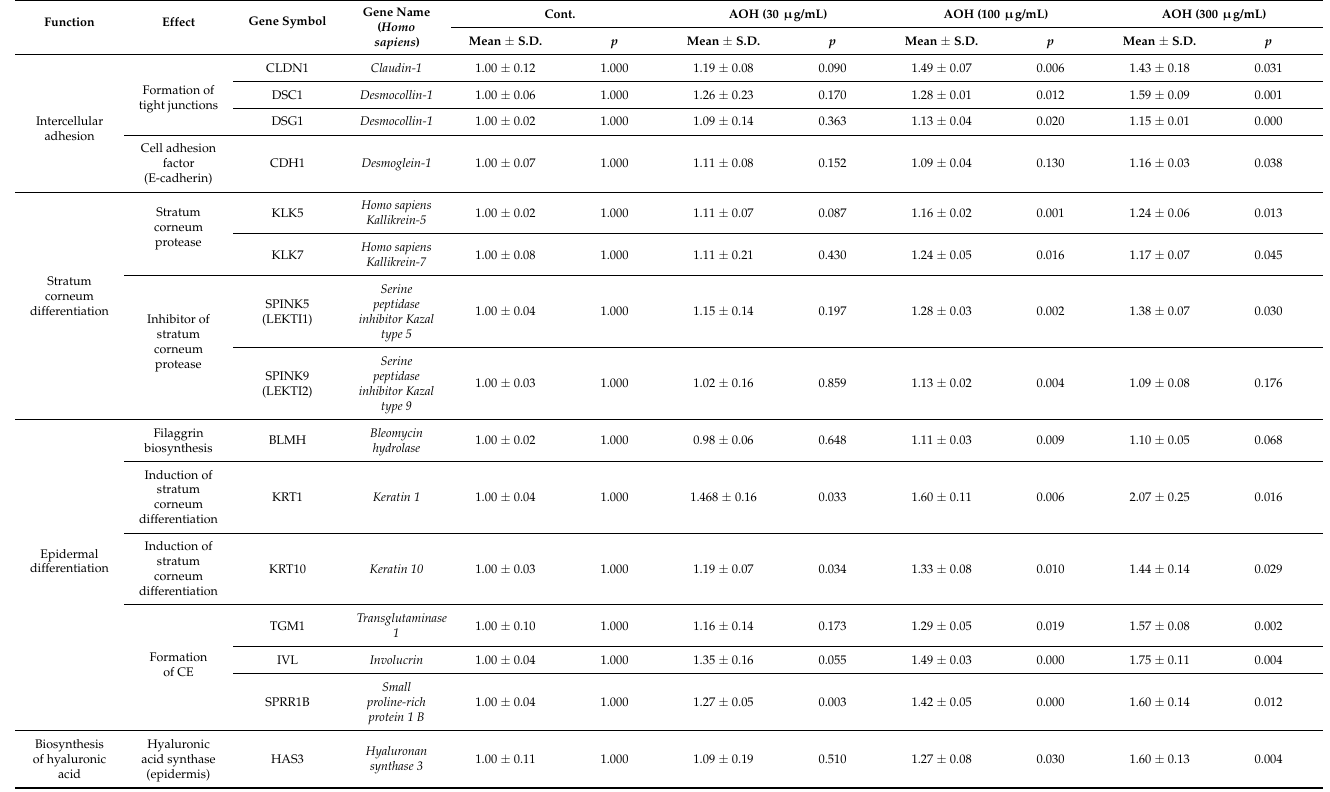
Table 1. Up-regulated genes involved in skin barrier functioning in normal human epidermal keratinocyte cells treated with 2-aza-8-oxohypoxanthine (AOH).